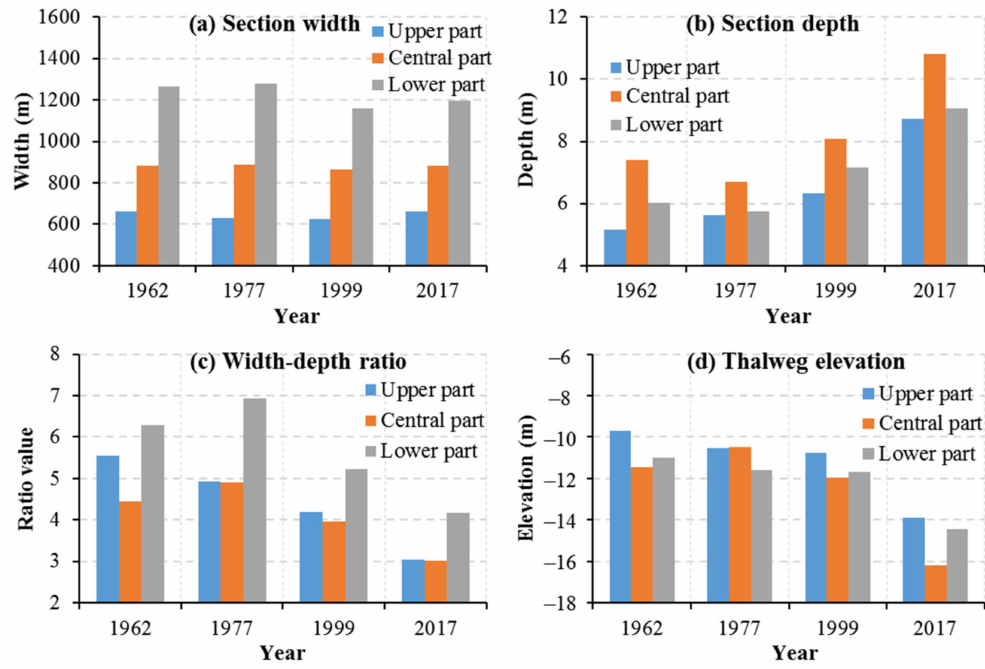
Figure 8. Mean value of section width ( a ), depth ( b ), width-depth ratio ( c ), and thalweg elevation ( d ) in the different zones from 1962 to